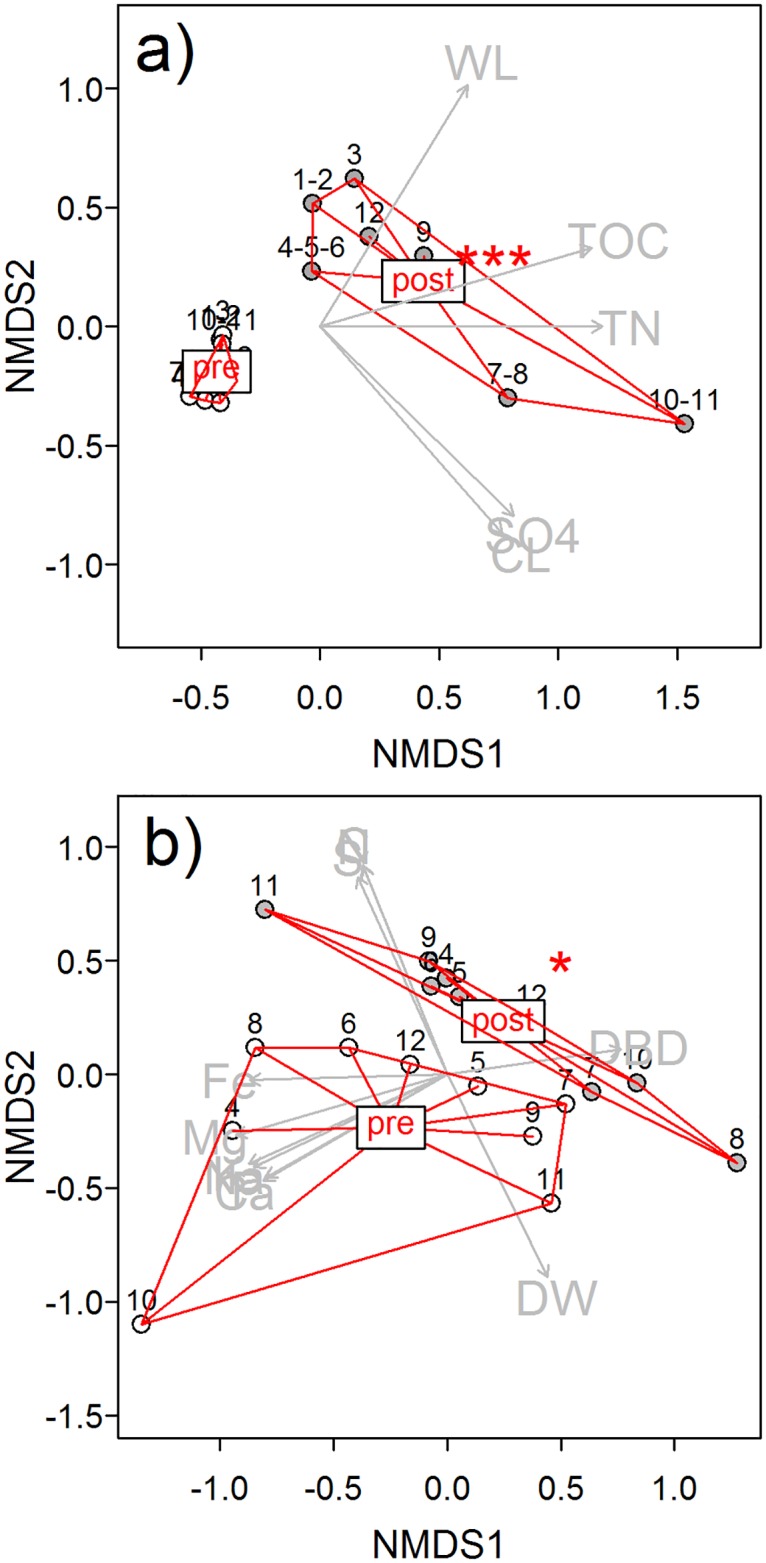
Properties of the a) peat water and b) peat (0-20cm) before (pre) and after (post) flooding.Spots which shared one dip well are represented by one data point. Only parameters that contributed significantly to the NMDS (p < 0.01) were included. Parameters included in peat water NMDS were water level (WL), the contents of total organic carbon (TOC) and nitrogen(TN), chloride (CL) and sulfate (SO4). Stress of the peat water NMDS was 0.012. Flooding significantly (p<0.001***) altered peat water characteristics. For pre-flooding peat water properties from the 25.11.2009 and for post-flooding those from the 25.11.2010 were used (n = 14).